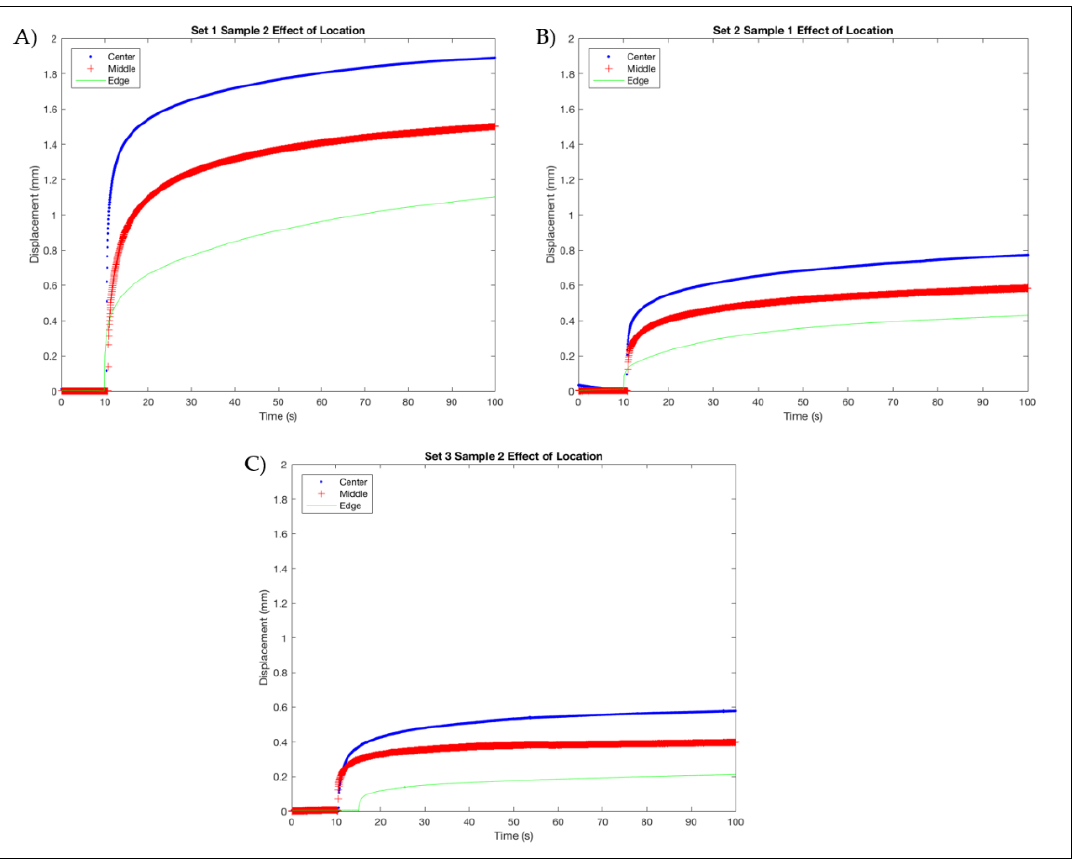
Figure 7. Displacement Curves across Multiple Geometries. ( A ) Set 1; ( B ) Set 2; ( C ) Set 3.